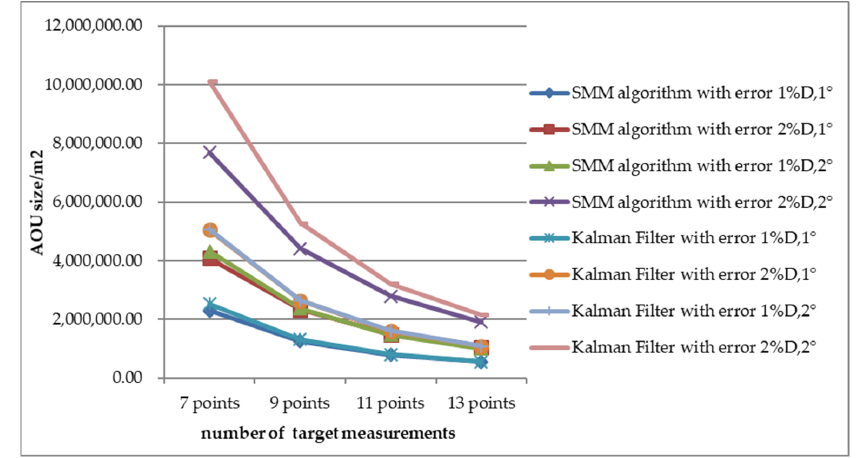
Figure 18. Comparison of estimated AOU size with different measurement errors.